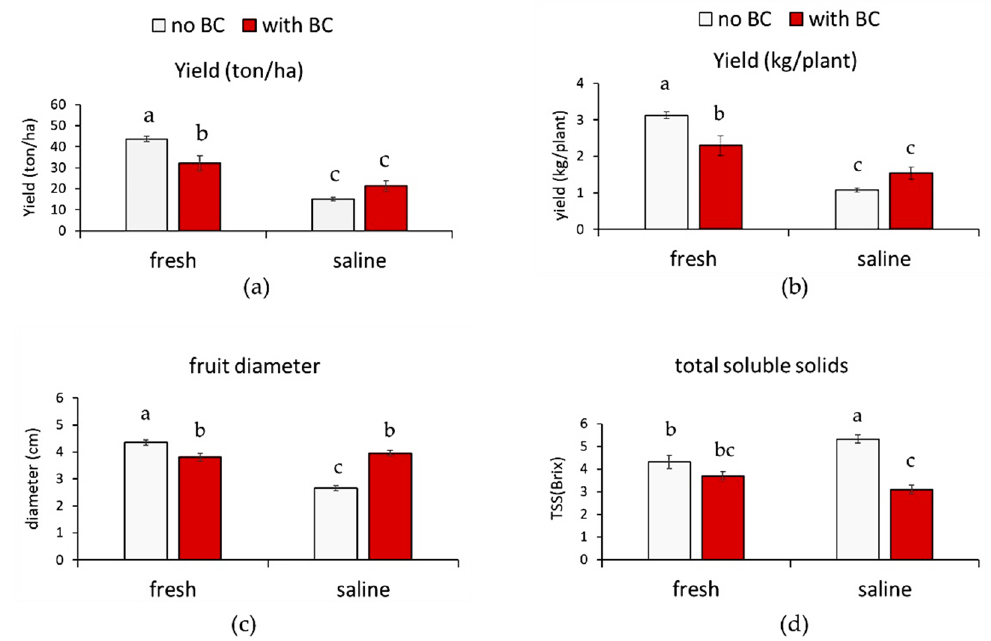
Figure 2. Effect of biochar addition on tomato plant response to salinity stress in terms of the following traits: ( a ) crop yield in ton/ha, ( b ) crop yield in kg/plant, ( c ) fruit diameter, and ( d ) fruit total soluble solids (TSS). Values represented the means of five biological replications (three plants each) ± SE (n = 120, two seasons). Means with the same letters are not significantly different according to Duncan’s multiple range test (DMRT) ( p ≤ 0.05).